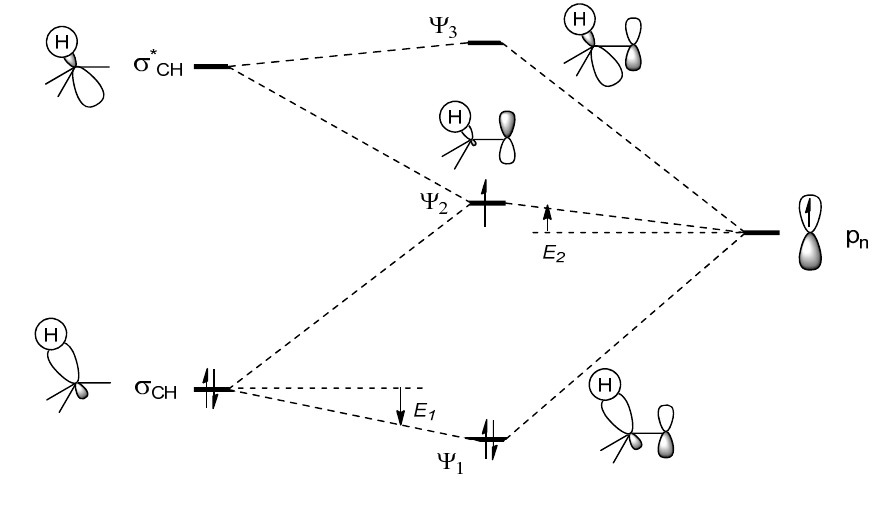
Figure 3. Interaction of the orbitals of a σ (C–H) -bond with a singly-occupied non-bonding 2p-orbital, comparable to the stabilization by hyperconjugation in carbenium